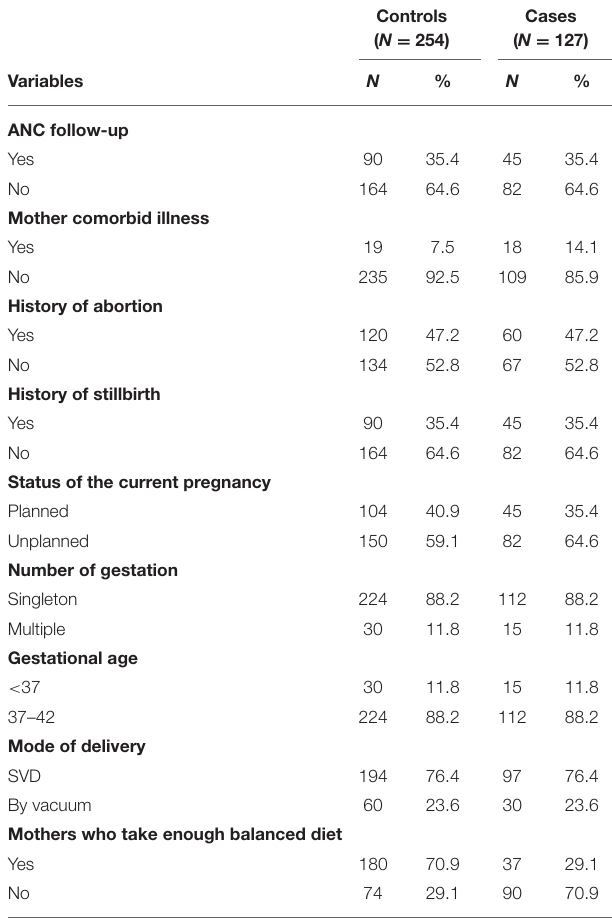
TABLE 1 | Frequency distribution of socio-demographic characteristics among case and control groups in Debre Berhan Specialized Hospital, 2021. Controls ( n = 254) Cases ( n = 127)